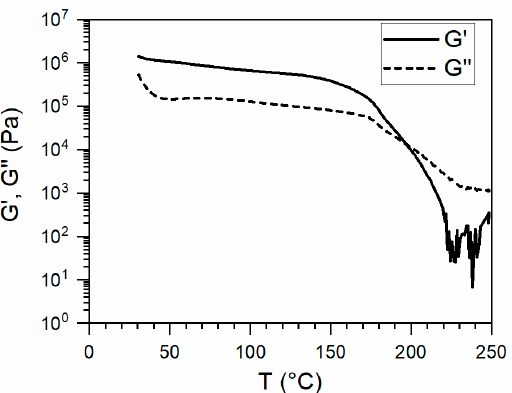
Figure 5. Temperature sweep rheology results of bulk SH-TPU at 1 °C/min and 1